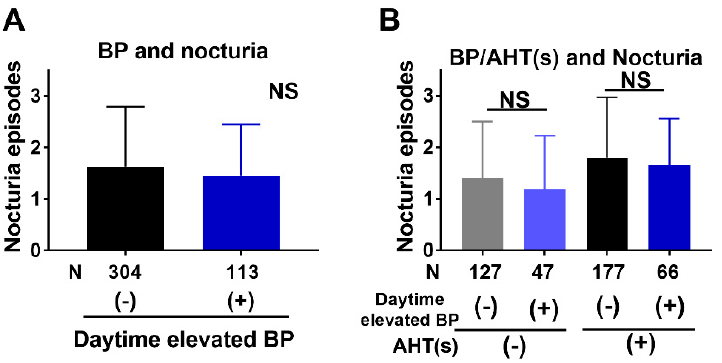
Figure 1. Nocturia was not associated with elevated BP. Daytime elevated BP was not associated with nocturia episodes ( A ), which was irrespective of taking AHTs or not ( B ). ( A ) Black and blue columns represent average of nocturia episodes in patients without and with BP elevation, respectively. ( B ) Gray and light blue columns represent average of nocturia episodes in patients without and with BP elevation in patients that do not take AHTs while black and dark blue columns represent those taking AHTs, respectively. BP: blood pressure, AHT(s): antihypertensive agents, NS: not significant, CCB: calcium channel blocker.